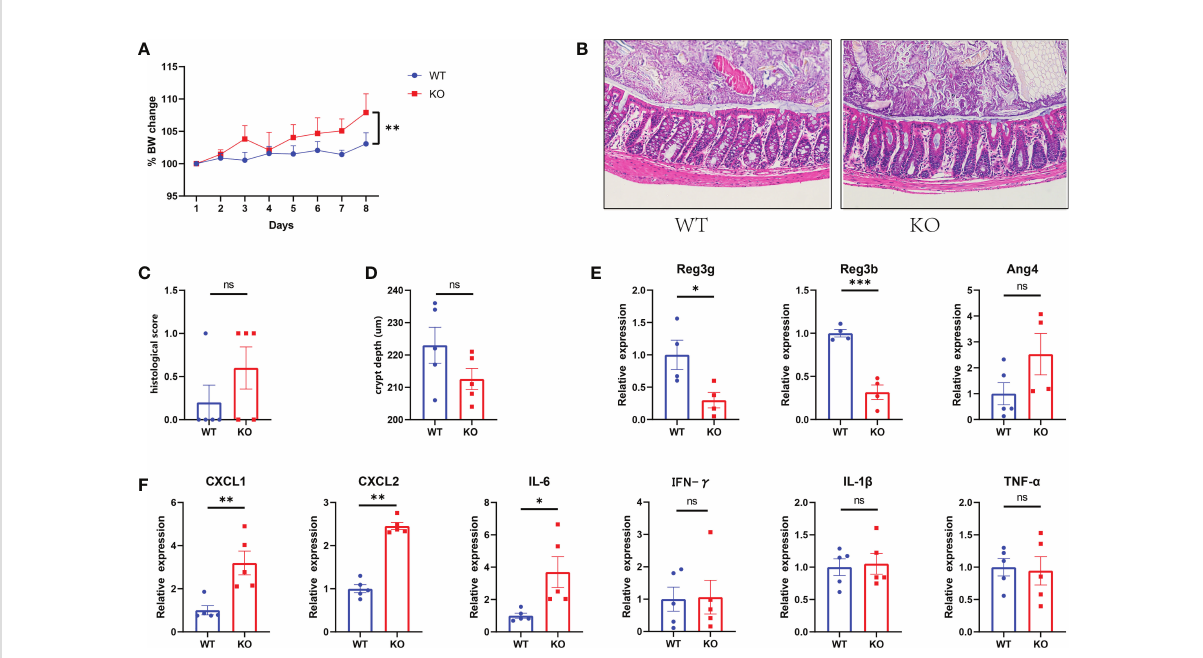
FIGURE 2 Tendency toward spontaneous in fl ammation in GC Piezo1 -/- mice. (A) The rate of body weight change. (B) Representative H&E staining images of colon tissue. 200×. (C) Histological scores of colons. (D) Colonic crypt depth was determined in sections with H&E staining. (E) The relative mRNA level of Ang4, Reg3b and Reg3g in colonic tissue. (F) The relative mRNA levels of CXCL1, CXCL2, IL-6, IFN- g , TNF- a and IL-1 b in colonic tissue. Data are expressed as the mean ± SEM. n =4-5. *p < 0.05, **p < 0.01, ***p < 0.001. ns, no signi fi